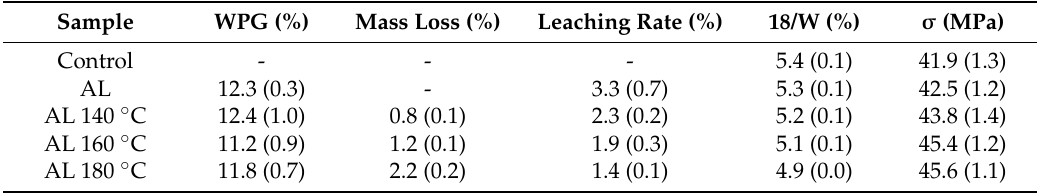
Table 1. Weight percent gain (WPG), mass loss, leaching rate, initial contact angle, 18/W, and compression strength ( σ ) of the samples. Number in parenthesis represents standard deviation from several